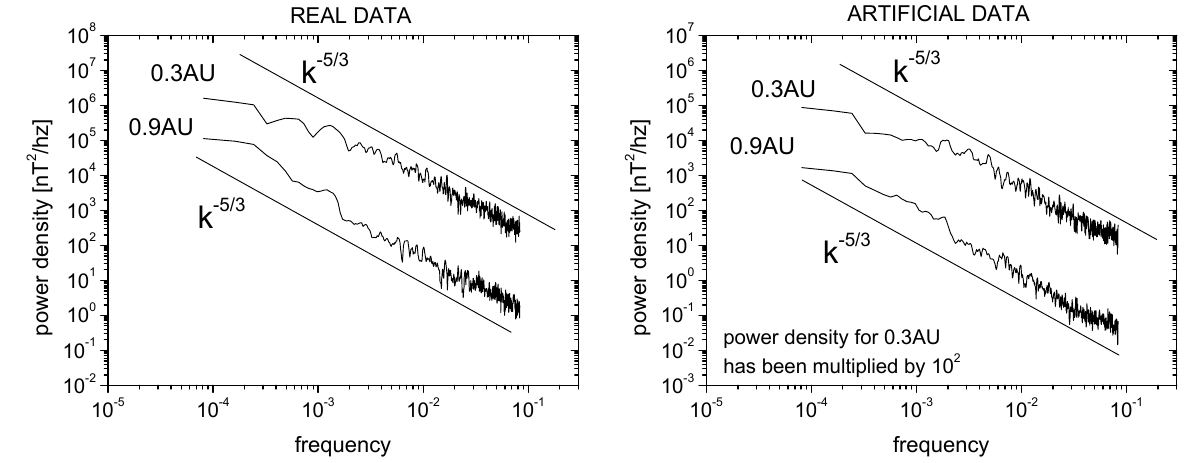
Fig. 16. The left panel shows power spectra obtained from the trace of the spectral matrix relative to magnetic field fluctuations recorded at 0.3 and 0.9AU by Helios 2 in 1976. Each time interval had 2048 averages of 6s each and are the same sub-intervals used for Figs. 2, 6, 7. The right panel shows power spectra obtained from the trace of the spectral matrix relative to the artificial field fluctuations relative to 0.3 and 0.9AU, built from a random walk whose jumps obey a double-lognormal distribution. Data relative to 0.3AU have been multiplied by a factor of 10 2 to facilitate visual comparison with real data shown in the left panel. It is worth noticing that artificial data, besides a general agreement with real data, are able to reproduce the bending of the power spectrum observed at 0.3AU. Straight solid lines indicate the k − 5 / 3 Kolmogorov slope. Table 6. Numerical simulation: Values of the parameters obtained from the fit of the PDF relative to vector displacements. Simulated